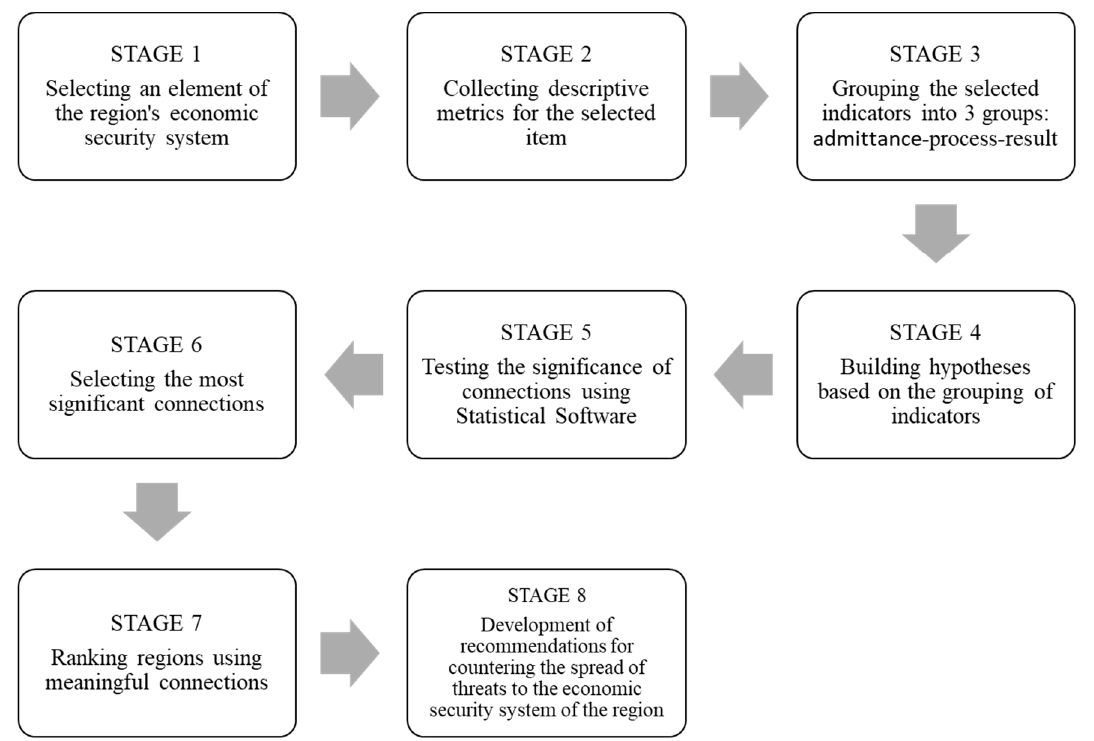
Figure 3. Stages of the method for assessing threats to the economic security of the region.